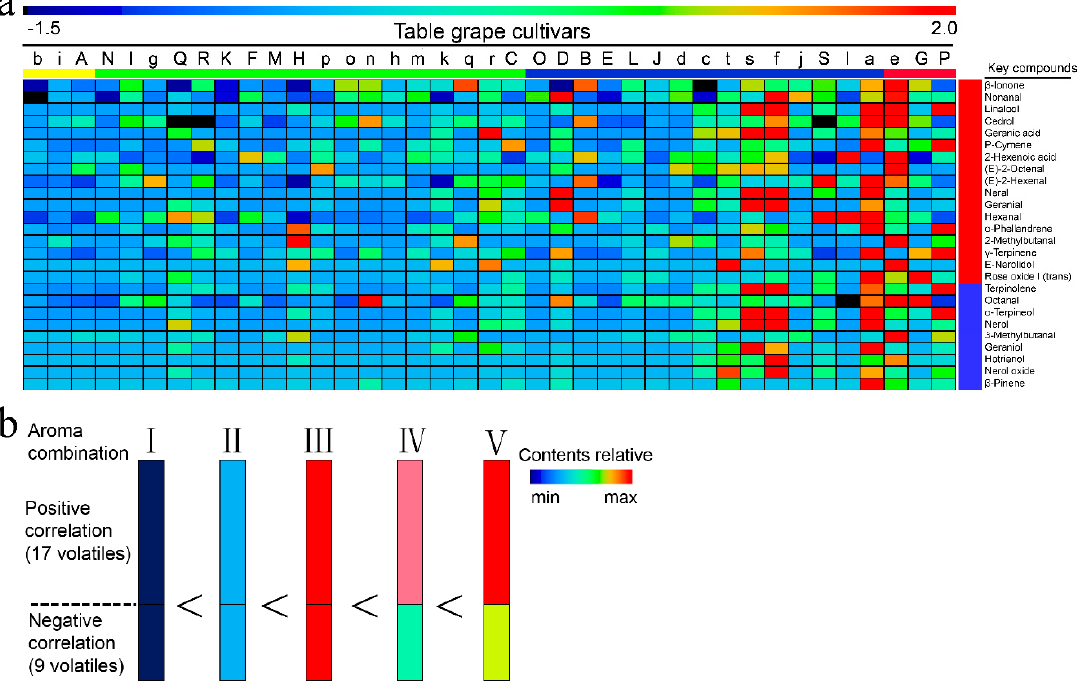
Figure 6. ( a ) Correlation between heatmap of key aroma compounds and the predicted aroma consumer liking (variable importance in projection (VIP) > 1). Upper and lower cases indicate table-grape cultivars, as listed in Figures 1 and 4. The yellow, green, blue, and red colors correspond to poor, average, good, and excellent aroma liking scores, respectively. The key compounds are listed in the right panel. Data are given as means. ( b ) The model of aroma combinations for all table grapes. In each combination, the upper part indicates the content of volatiles for positive relationships, and the lower part represents the content of volatiles for negative relationships.